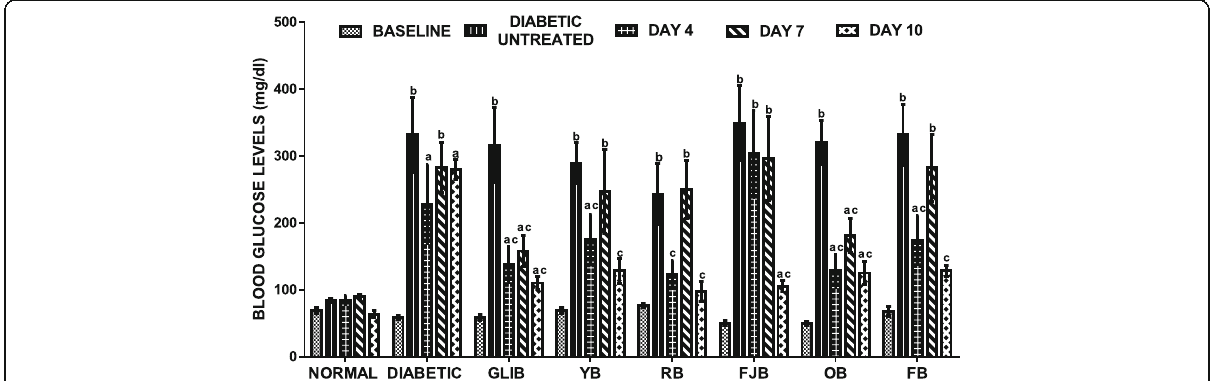
Fig. 1 effects of polyherbals on fasting blood glucose (FBGL) levels in normal and diabetic rats. Results represented as Mean ± S.E.M. n = 6. a p < 0.05 or b < 0.001 different from control normal CMC group. c p < 0.05 or d < 0.001 different from control Untreated Diabetic group. CMC: Carboxylmethyl cellulose; YB: Yoyo bitters; RB: Ruzu bitters; FB: fajik bitters; OB: Oroki bitters; FB: Fidson